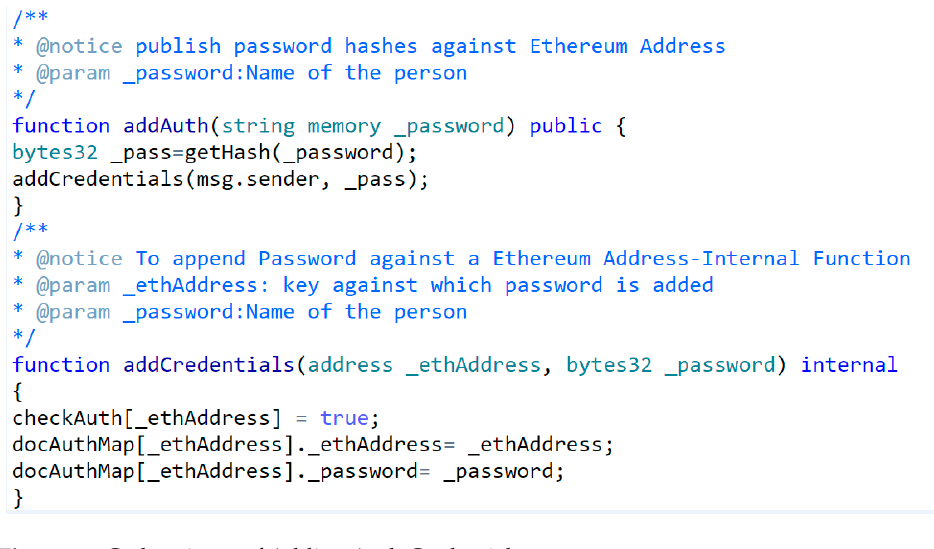
Figure 15. Code snippet of Hashing.